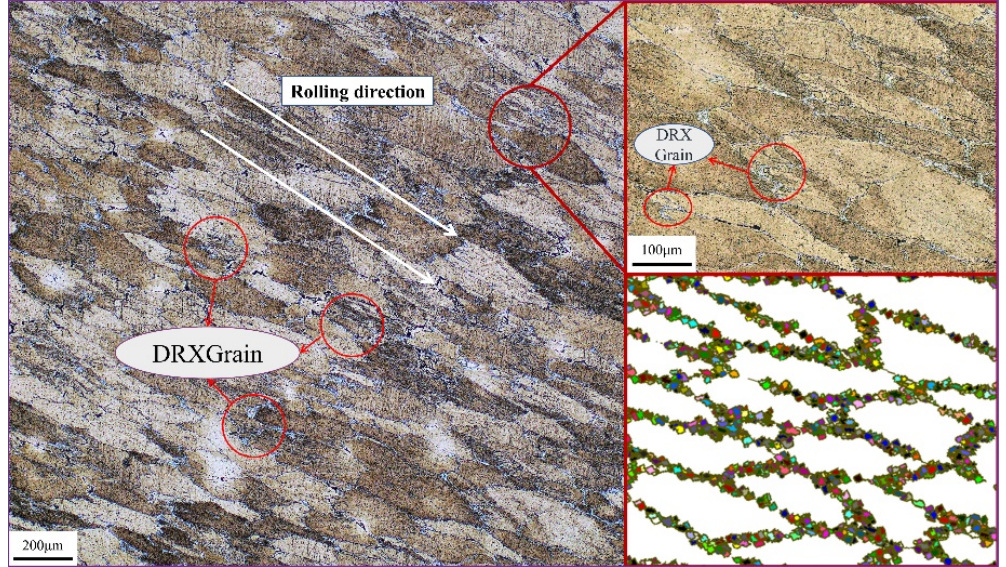
Figure 16. C omparison of the microstructure between the CA simulation and the experimental re-